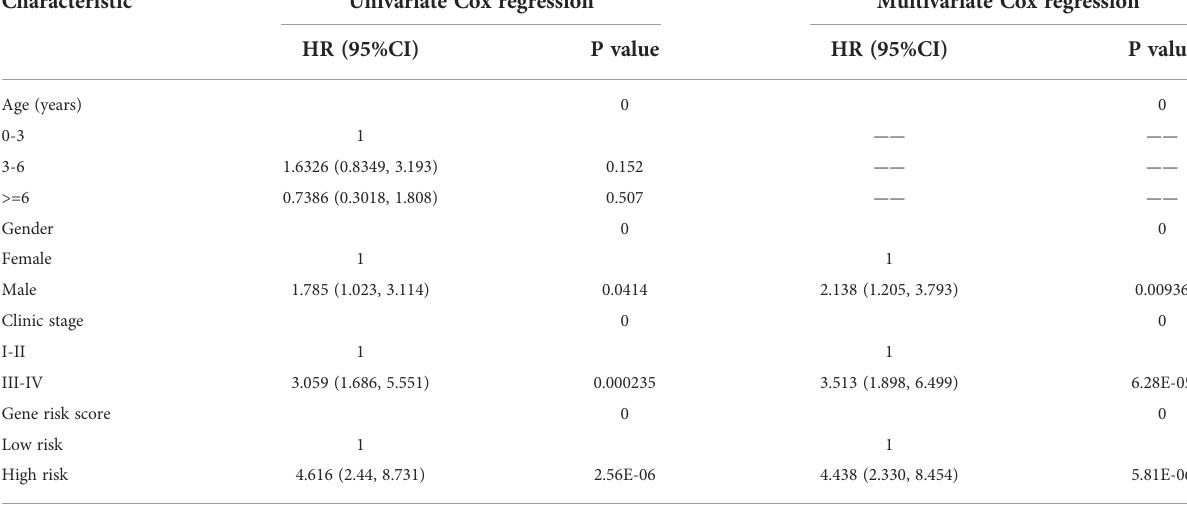
TABLE 3 Univariate and multivariate Cox regression analysis of different prognostic variables for overall survival (OS) prediction in Wilms tumor patients. Characteristic Univariate Cox regression Multivariate Cox regression